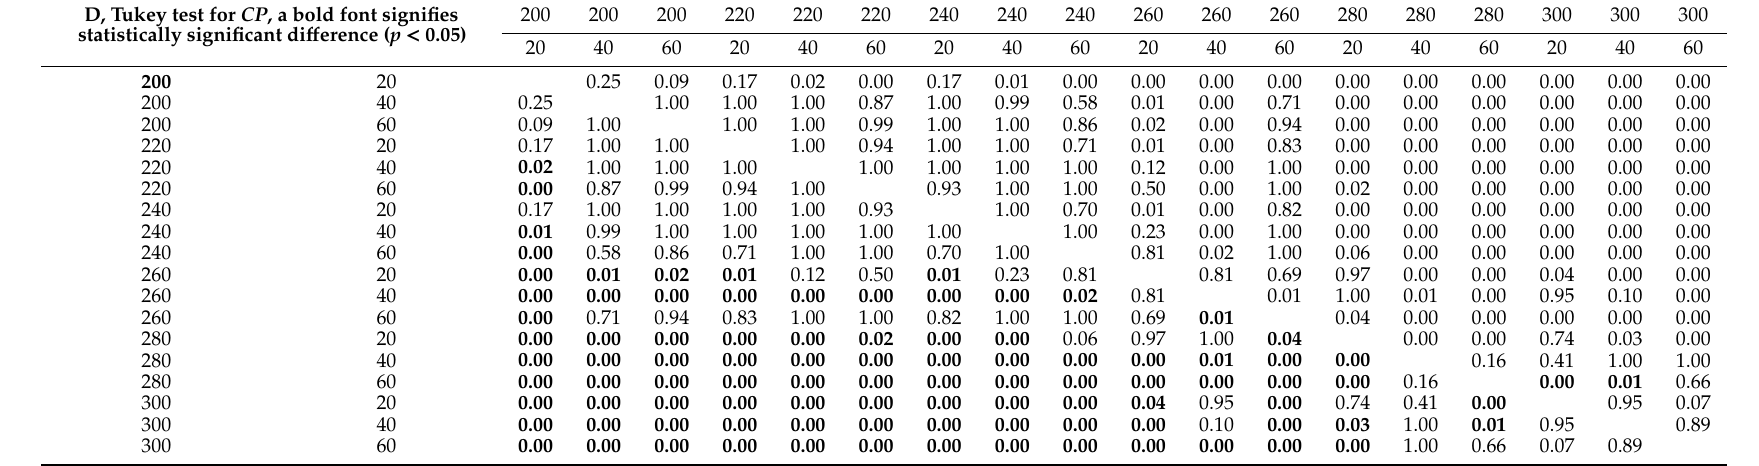
Table A13. Analysis of variance for combustible parts content of